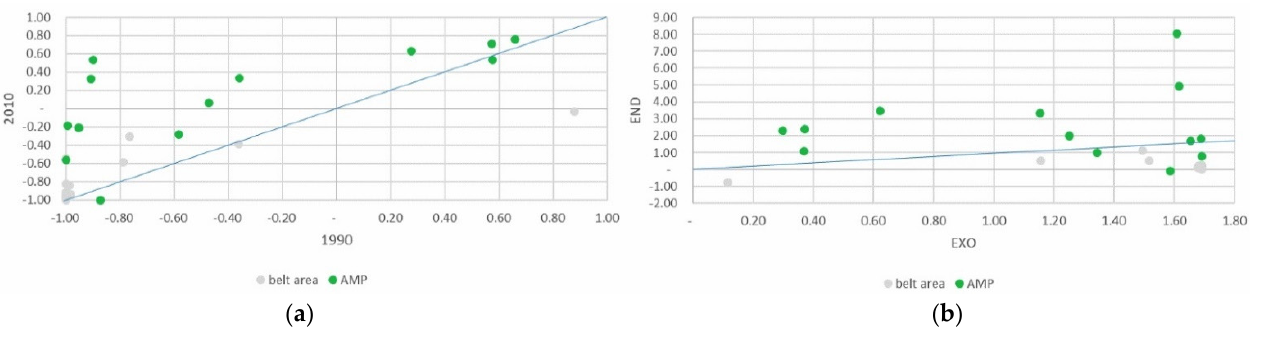
Figure 13. ( a , b ) AMP-2010 crop distribution and variation in the UAA between 1990 and 2010. Source: Drawn up by the authors using data from the ISTAT.